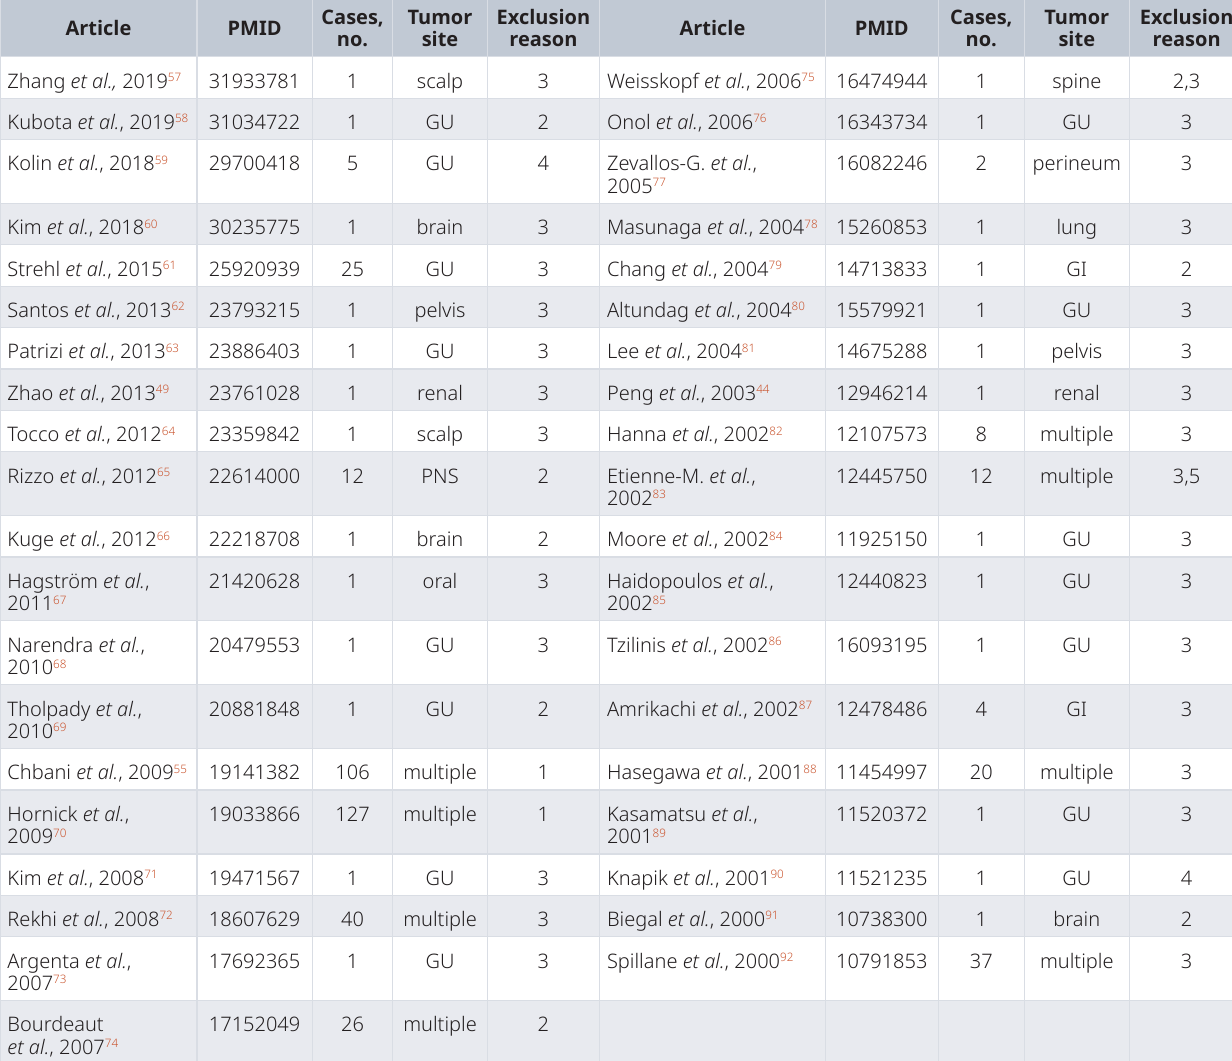
Table 2. Excluded rare sarcomas in adults reported in single case reports, case series, or systematic reviews, 2000–2020. Exclusion criteria were as follows: 1.) individual patient age could not be confirmed; 2.) pediatric study population (less than 18 years of age); 3.) absence of documentation noting the loss of SMARCB1/INI1 expression by immunohistochemistry or genetic studies; 4.) intact SMARCB1/INI1 expression by immunochemistry or genetic studies; and 5.) non-sarcomatous histologic tumor type. PMID,